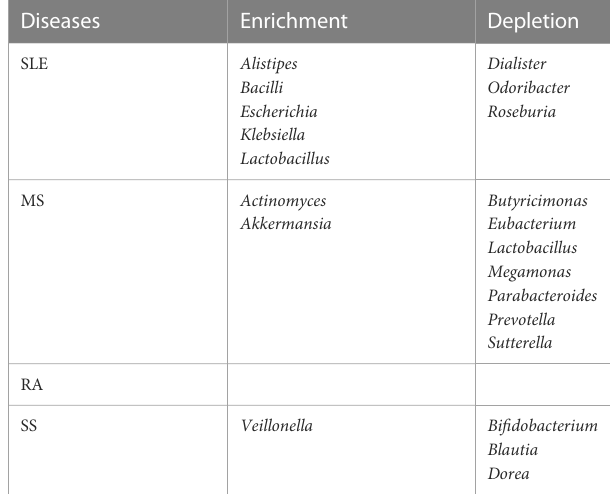
TABLE 3 Altered gut bacteria unique to each autoimmune